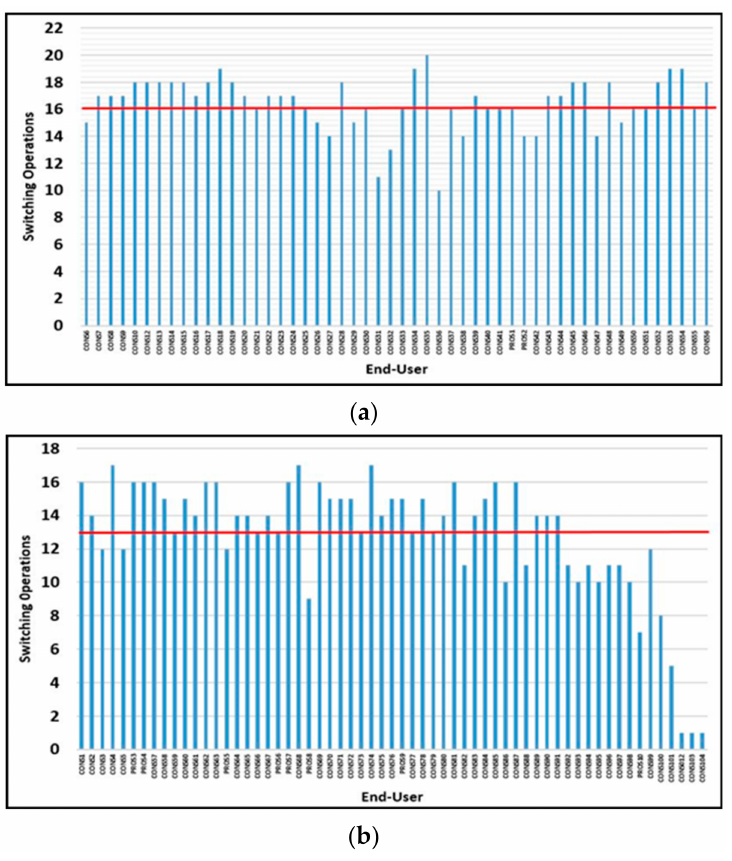
Figure 13. The number of switching operation performed by SSDs ( a )—main trunk; ( b )— lateral branch.